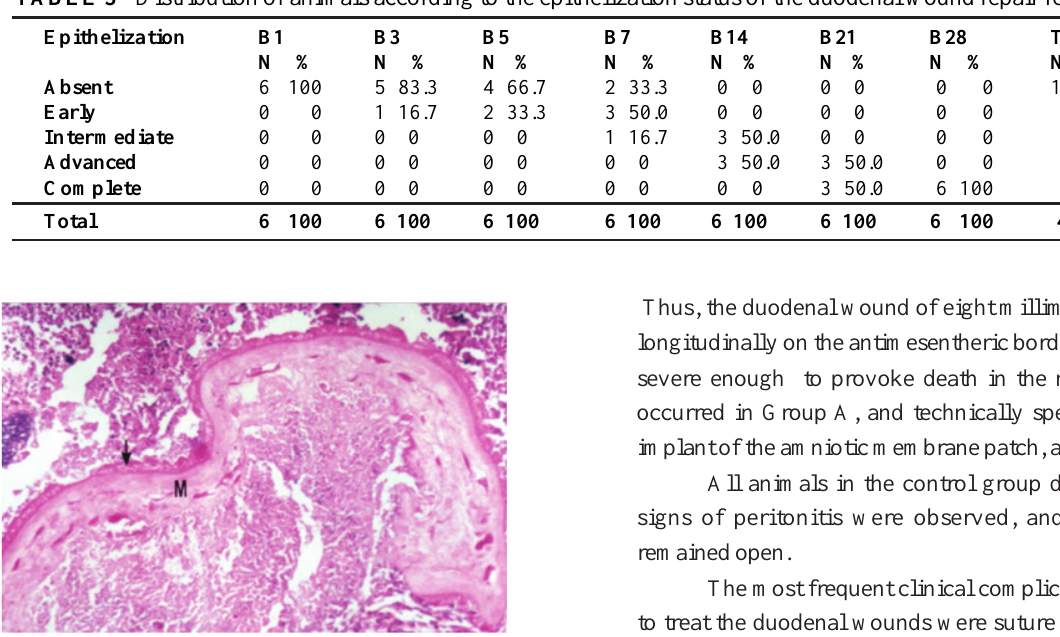
FIGURE 4 - Demonstrates epithelization over the amniotic membrane (AM)